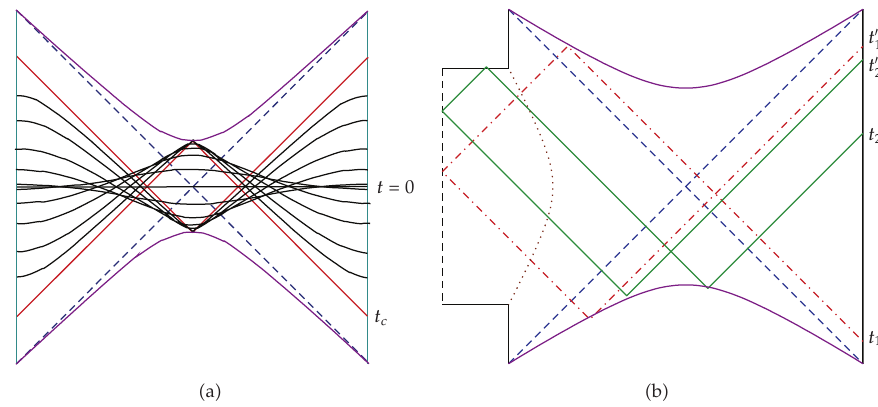
Figure 7: Illustration of mapping out bulk causal structure by analytically continued correlators, as discussed in (cid:5) 166 (cid:6) for the Schwarzschild-AdS 5 spacetime (cid:3) left panel (cid:4) and in (cid:5) 171 (cid:6) for a more complicated geometry describing de Sitter universe behind the horizon of a Schwarzschild-AdS black hole (cid:3) right panel (cid:4) . In both Penrose diagrams, the vertical solid lines represent the AdS boundaries, the top and bottom (cid:3) purple (cid:4) curves the curvature singularities, and the dashed diagonal lines the horizons; on right the horizontal lines are de Sitter boundaries, the vertical dashed line the de Sitter origin, and the vertical (cid:3) brown (cid:4) curve a domain wall separating the dS and SAdS regions. All other curves correspond to the geodesics discussed in the